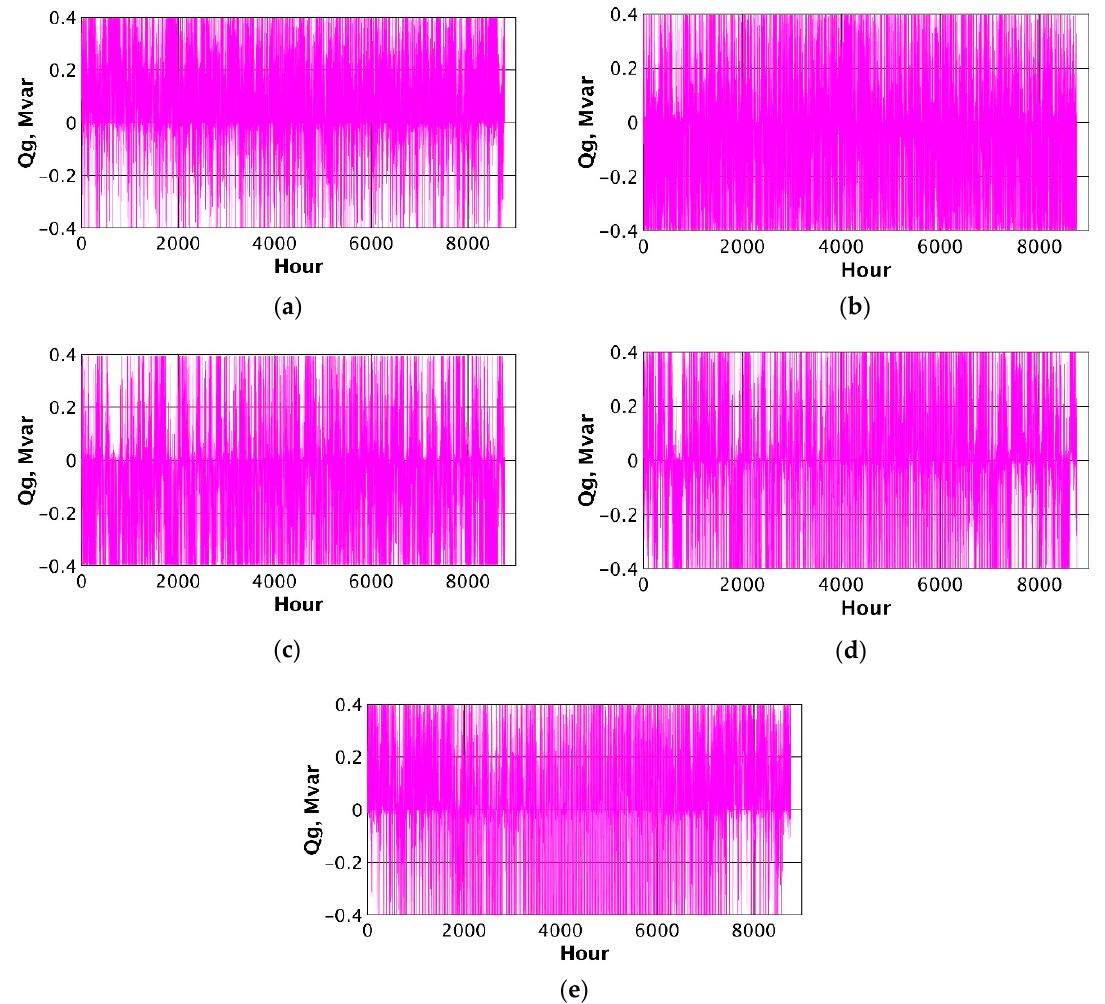
Figure 11. Changes in reactive power generation and consumption of individual RES in the voltage regulation process according to the OPFh-MVt method ( a ) G1, ( b ) G2, ( c ) G3, ( d ) G4, ( e ) G5.